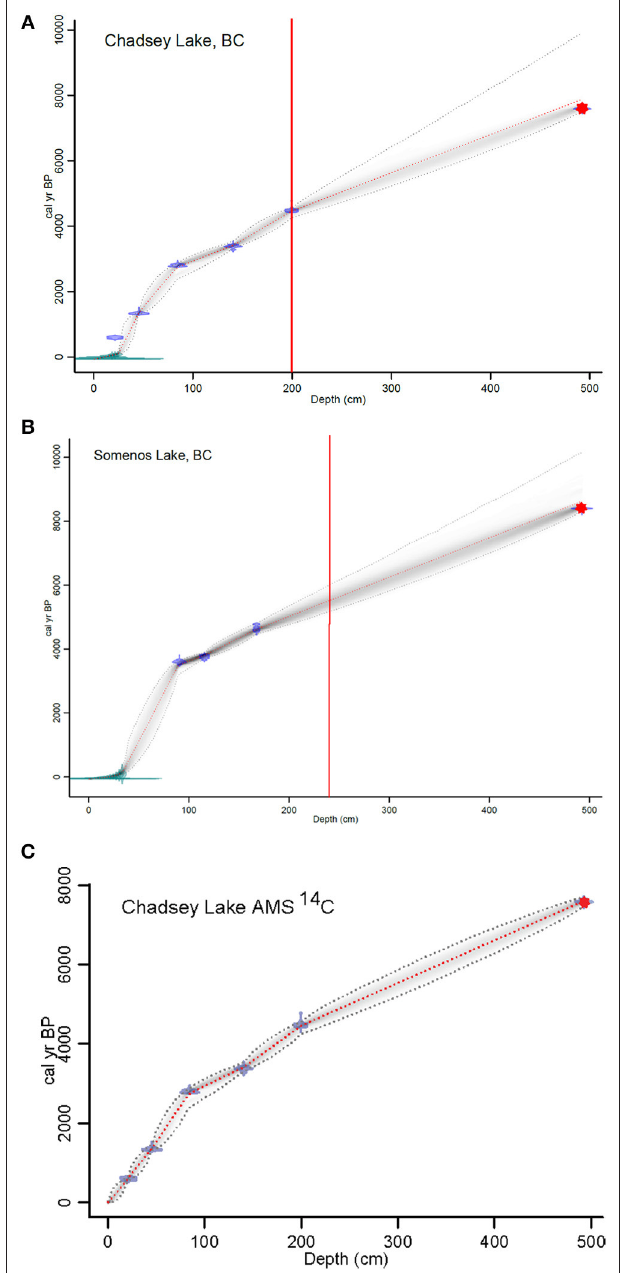
FIGURE 2 | Bayesian age-depth models for Somenos and Chadsey lakes composite cores. (A) Age-depth model (cm/yr) for Chadsey Lake using 210 Pb ages based on Constant Rate of Supply Model (SRS), AMS 14 C dates and Mount Mazama tephra (7,590 cal yr BP) incorporated into a Bayesian age model (Bacon v2.2). (B) Age-depth model (cm/yr) for Somenos Lake using 210 Pb ages based on Constant Rate of Supply Model (SRS), AMS 14 C dates and Mount Mazama tephra (7,590 cal yr BP) incorporated into a Bayesian age model. (C) Age-depth model (cm/yr) for Chadsey Lake using AMS 14 C dates and Mount Mazama tephra (7,590 cal yr BP) incorporated into a Bayesian age model. For (A,B) green represents 210 Pb ages, blue represents AMS 14 C ages, and the red star represents Mazama tephra. The red line indicates the lower limit of charcoal analyses. In (C) blue represents AMS 14 C ages and the red star represents Mazama